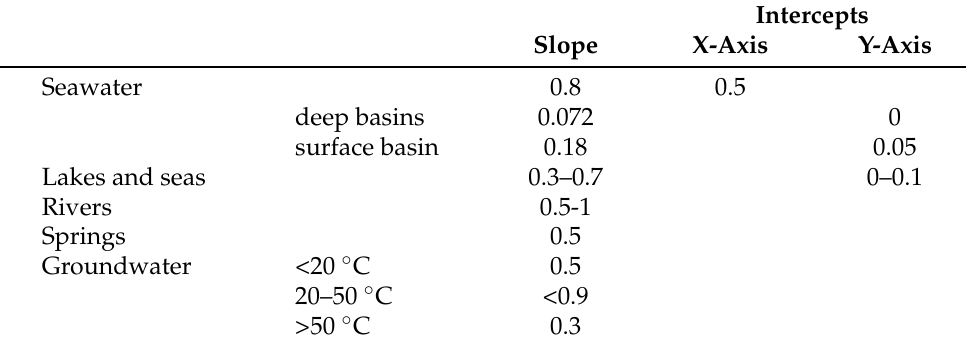
Table 1. Slopes in Gd vs. Y anomalies in natural waters. Slope equals the ratio of (Gd/Gd ∗ - 1)/(Y n /Ho n